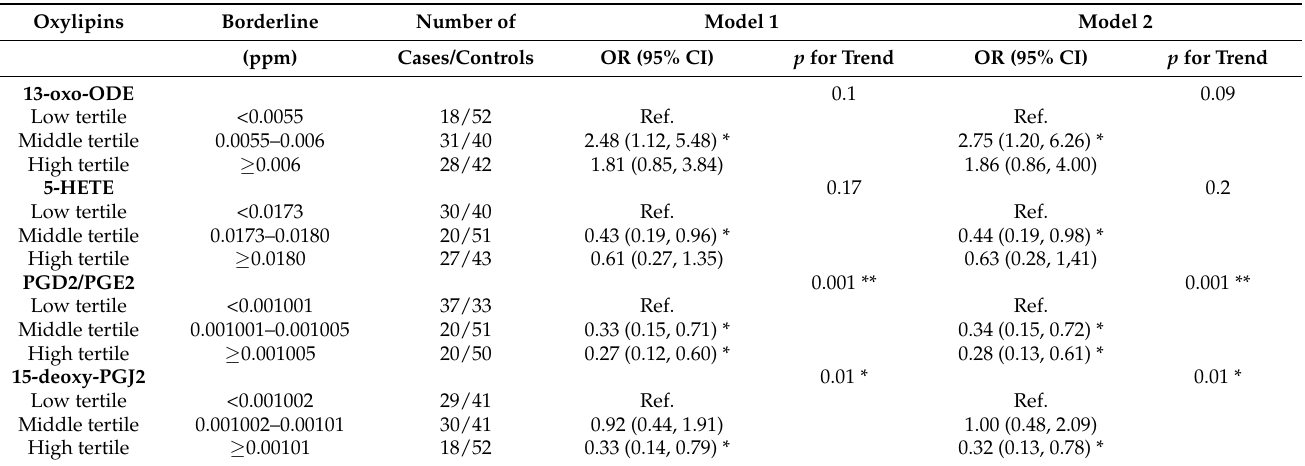
Model 1: Adjusted for hypertension, diabetes mellitus, hypertriglyceridemia, hypercholesterolemia, drinking, smoking, and experimental batch effects. Model 2: Adjusted for above variables and education level. * p -value <